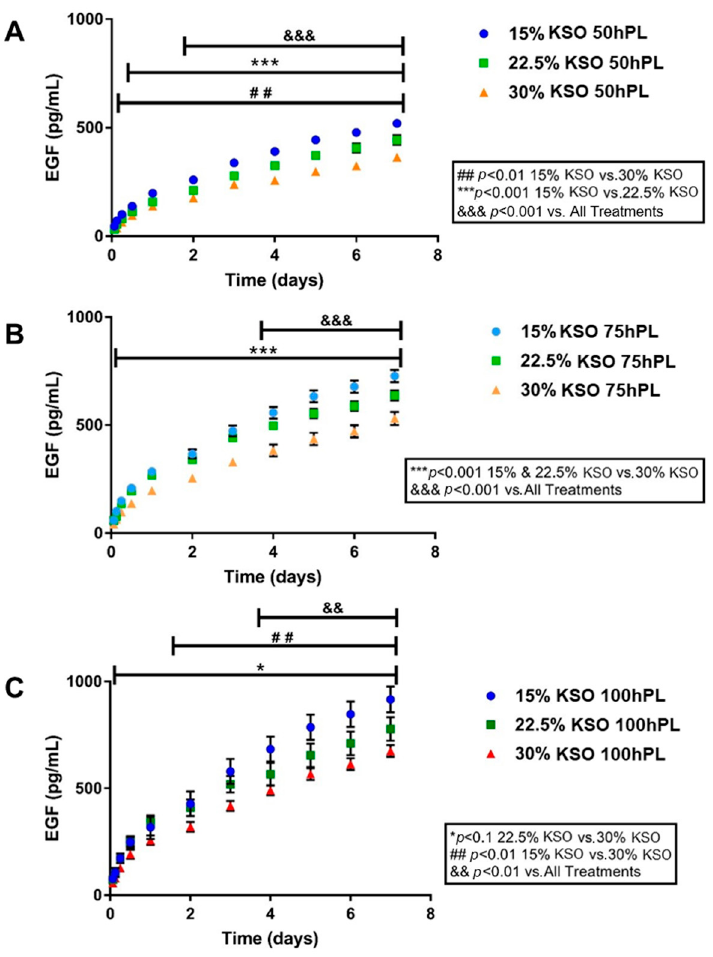
Figure 5. EGF release against varying KSO concentrations. EGF release was plotted against varying KTN concentrations for 50 hPL ( A ), 75 hPL ( B ), and 100 hPL ( C )—loaded hydrogels over the course of 7 days. For each hPL-loading condition, increase KTN concentration correlated with decrease in EGF release.